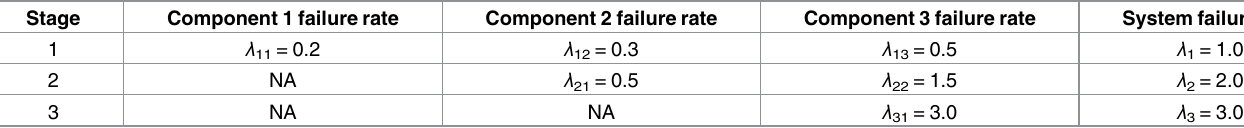
Table 1. Pre-specified parameters for exponential numerical example.